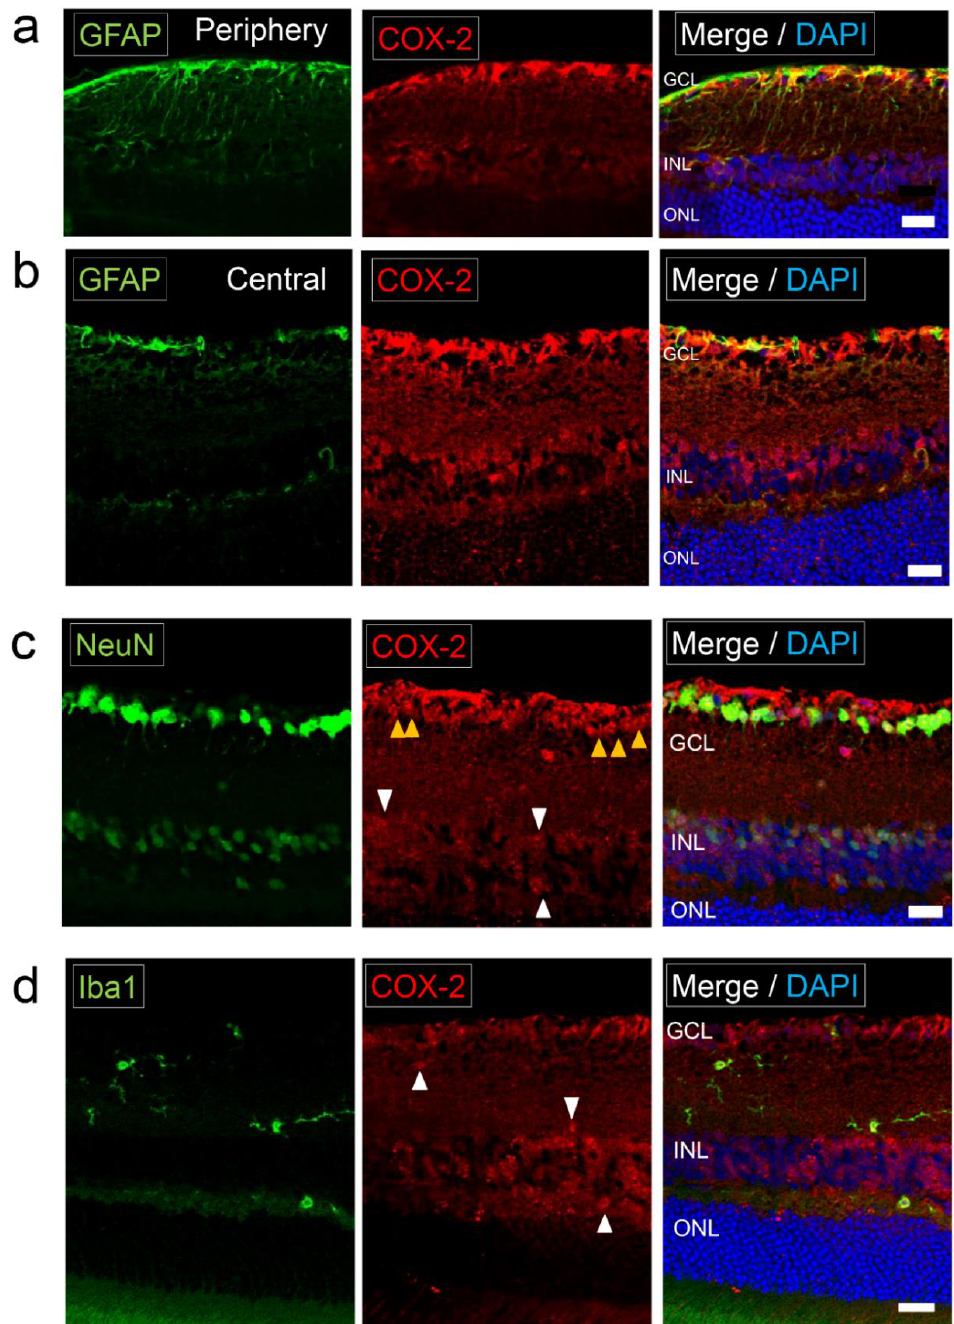
Figure 2. Expression of COX-2 in normal retina. Photomicrographs of the retina in normal C57BL/6J mice ( a ) The retinal section of the peripheral area labeled with GFAP (astrocyte/Müller cell marker) and COX-2. COX-2 was positive in GFAP + cells. GFAP-positive vertical lines (Müller cells) were not clearly COX-2 positive. Scale bar, 20 μm. ( b ) The retinal section of the central area labeled with GFAP and COX-2. COX-2 staining coincided with GFAP staining. Scale bar, 20 μm. ( c ) The retinal section labeled with NeuN (neuronal marker) and COX-2. COX-2 was positive in NeuN + neurons in the GCL (yellow arrowheads) and the INL (white arrowheads). Scale bar, 20 μm. ( d ) The retinal section labeled with Iba1 and COX-2. Iba1 + cells were ramified microglia with processes. COX-2 was weak positive in Iba1 + ramified microglia (white arrowheads). Scale bar, 20μm.